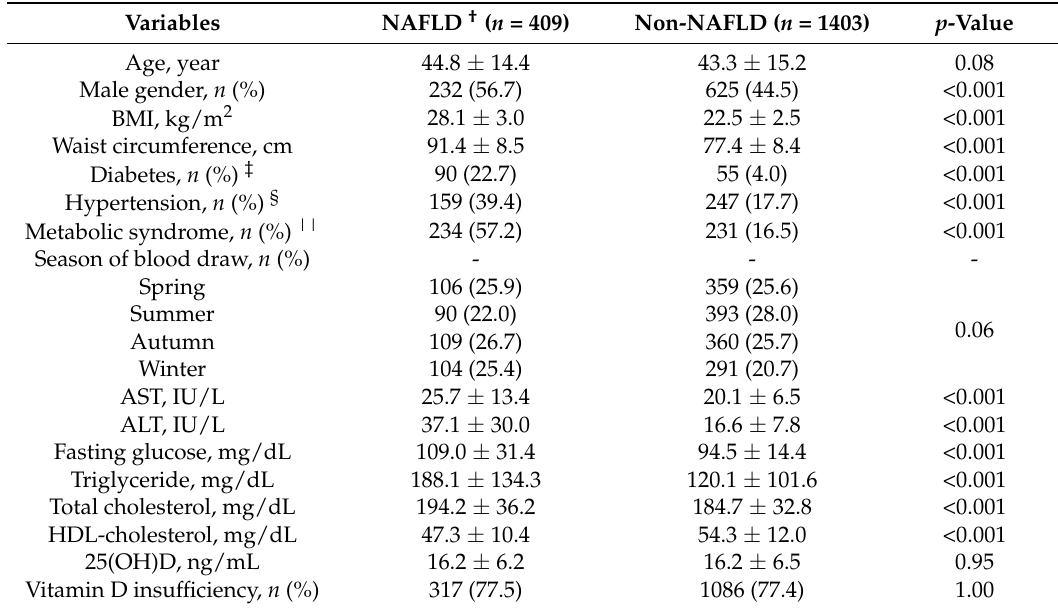
Table 1. Baseline characteristics of the participants